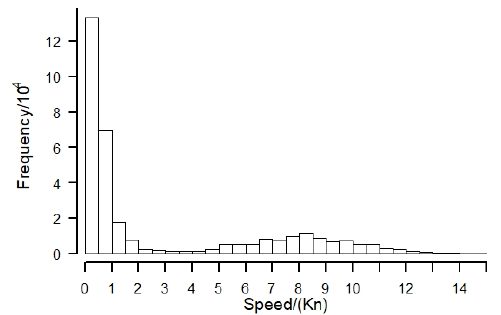
Figure 2. Histogram of speed frequency distribution.